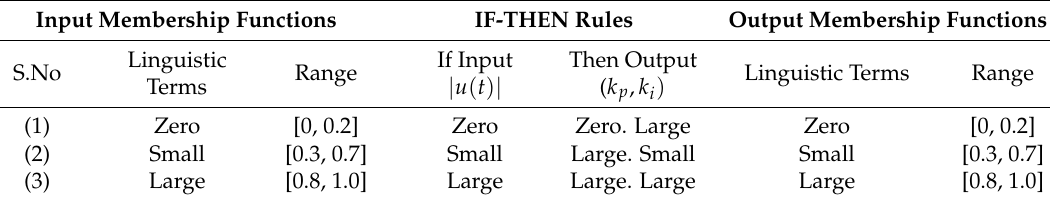
Table 2. IF-THEN rules employed for gain